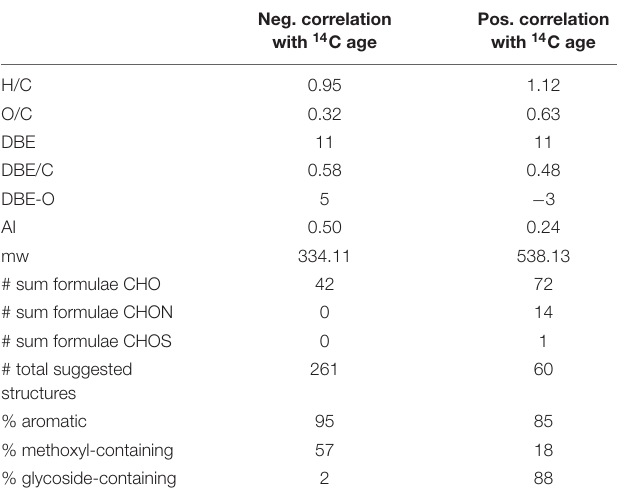
TABLE 2 | Molecular information from FT-ICR-MS and correlation with cal. 14 C age.